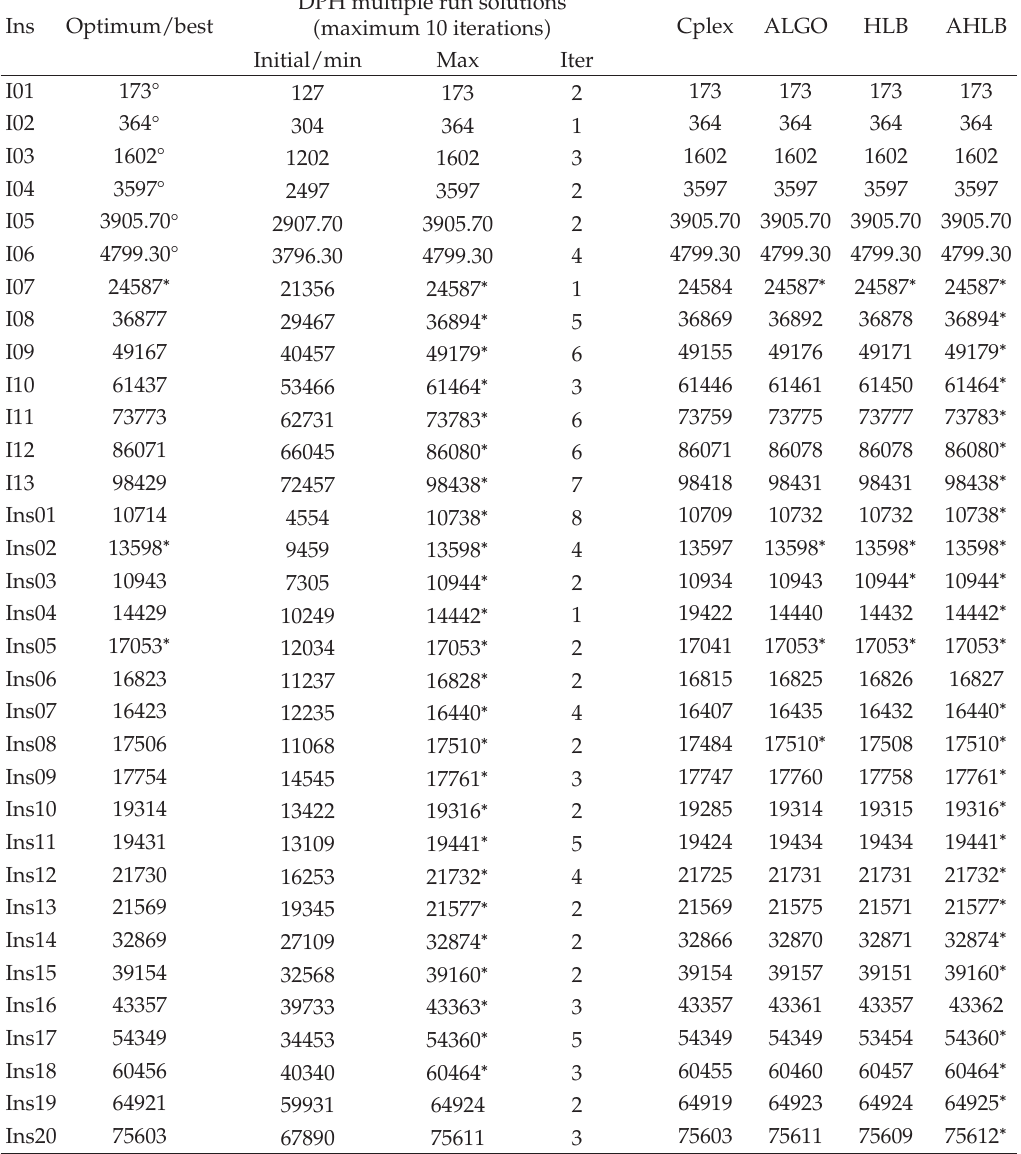
Table 2: Computational results of Cplex, ALGO, HLB, AHLB, and DPH with known optimum/best (cid:4) 8 (cid:5)